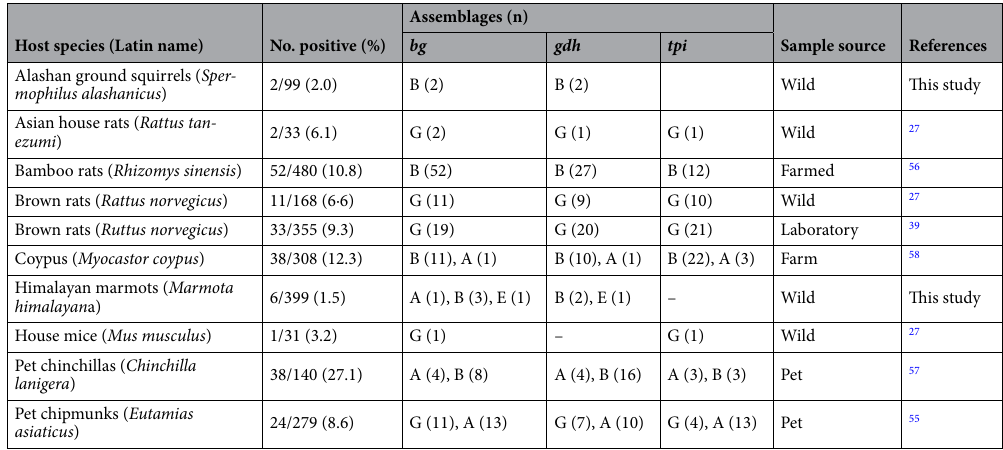
Table 3. G. duodenalis assemblages in rodents in